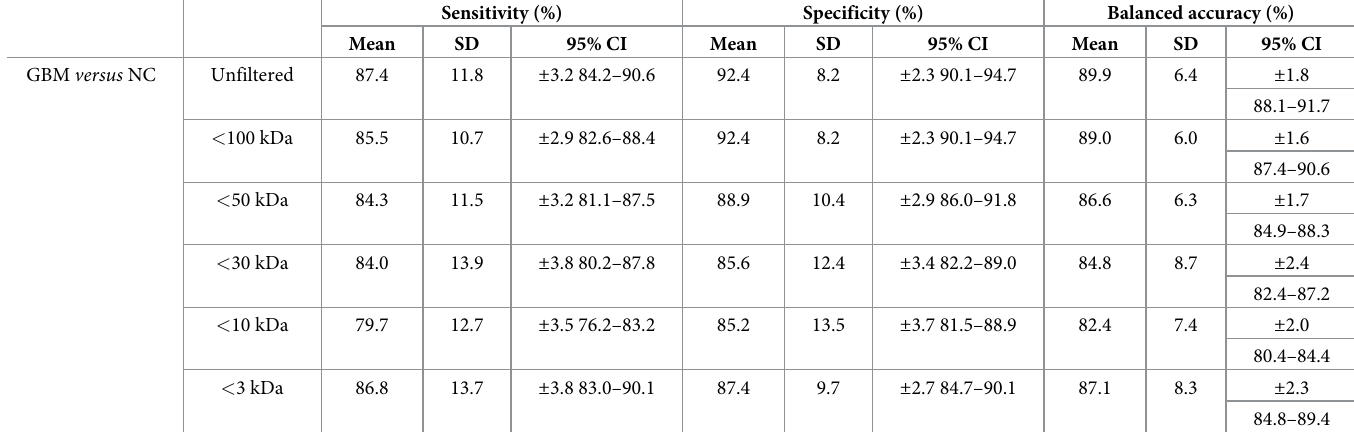
Table 1. Sensitivity, specificity and balanced accuracies for the PLS-DA model classification of GBM versus non-cancer patients. Mean, standard deviation (SD) and 95% confidence intervals (CIs) are provided.